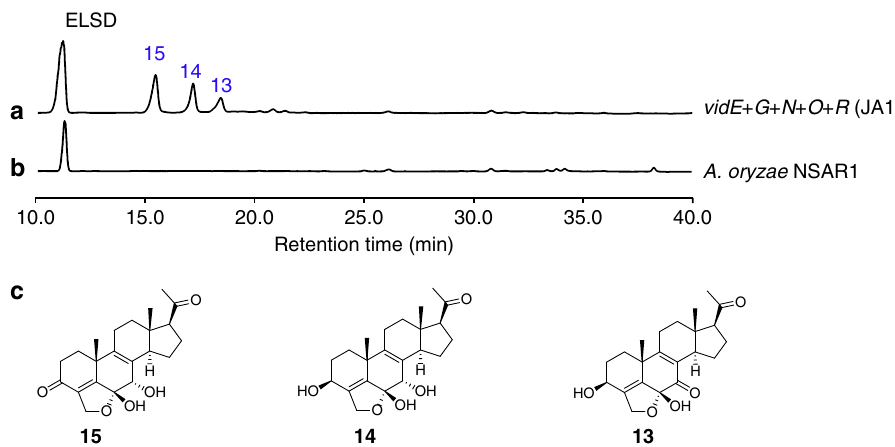
Fig. 4 HPLC analysis of culture extract of JA1. a A. oryzae harboring vidE , vidG , vidR , vidN , and vidO (JA1). b A. oryzae . c Structures of compounds 13 – 15